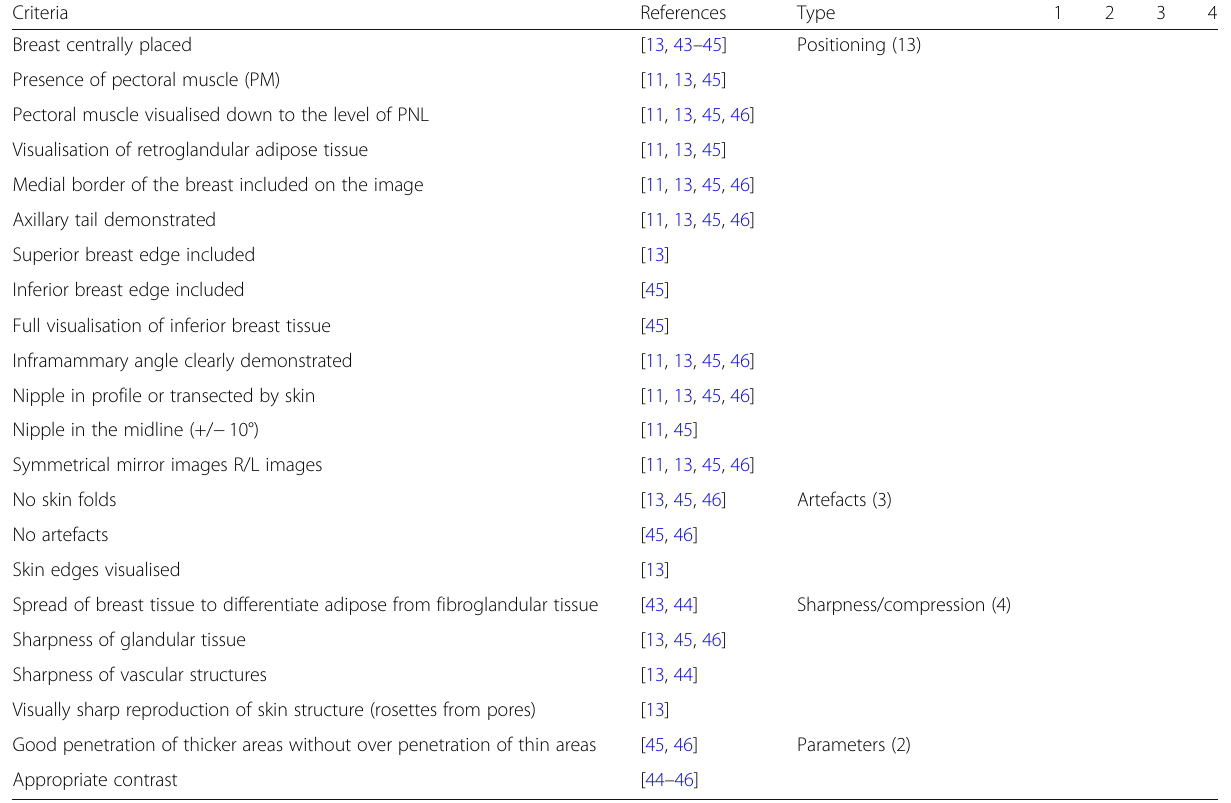
Table 1 Criteria to assess mammography examinations grouped by type (positioning, artefacts, sharpness, parameters) in craniocaudal, mediolateral oblique and mediolateral mammograms Criteria